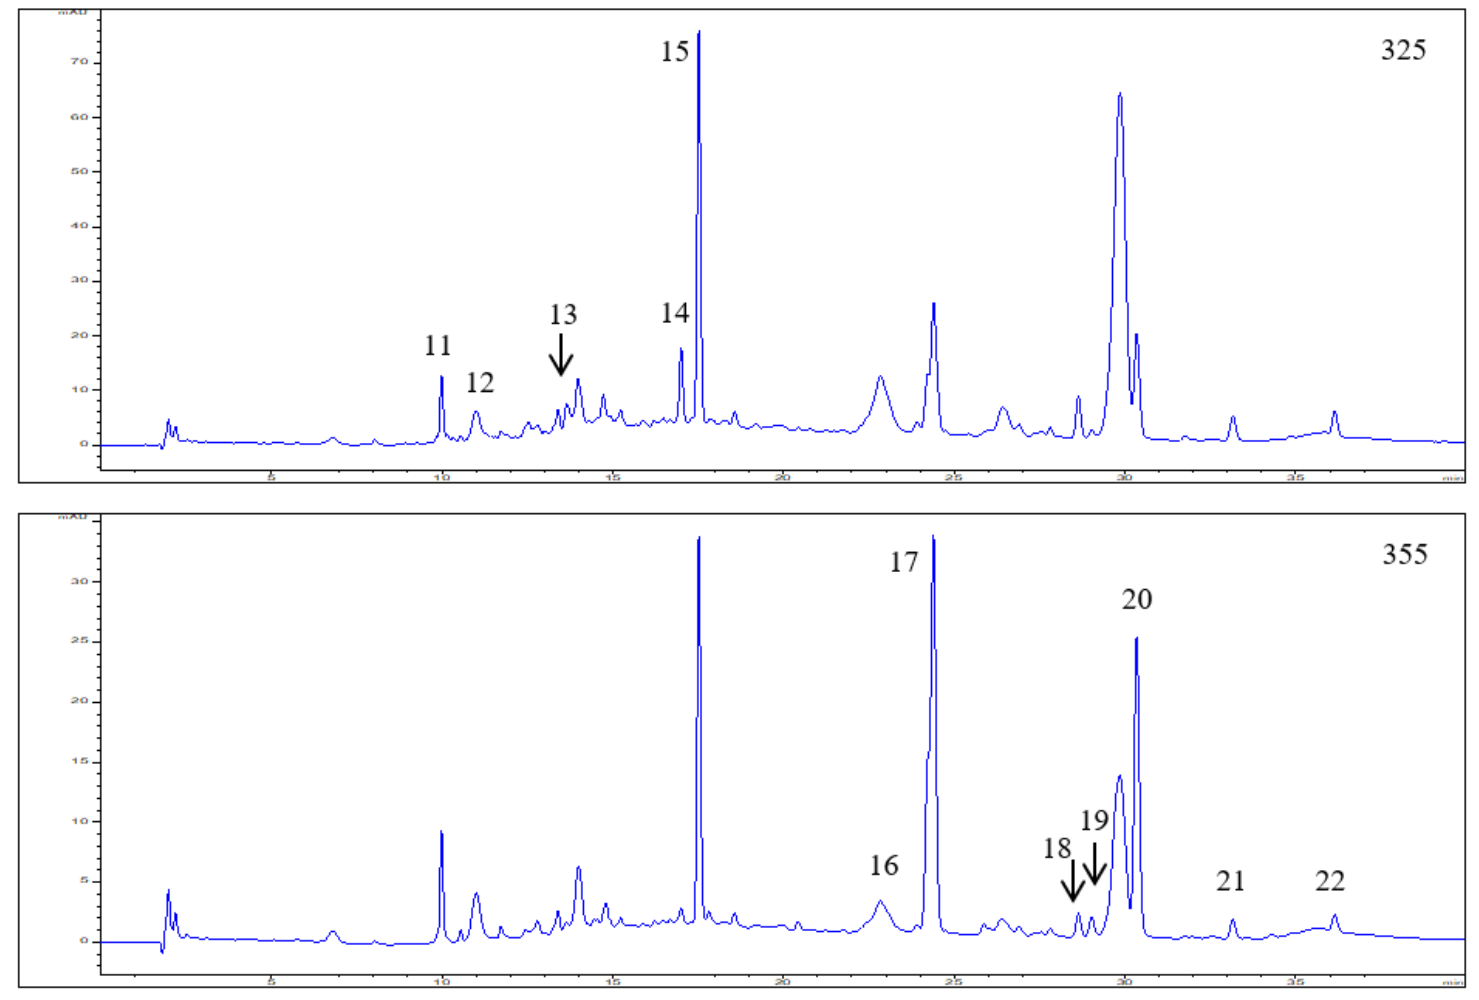
Figure 1. HPLC-DAD chromatograms of elderberry ( Sambucus nigra L.) fruit extract recorded at 520, 280, 325, and 355 nm, respectively. Peak numbers and retention times refer to compounds indicated in Table 2.